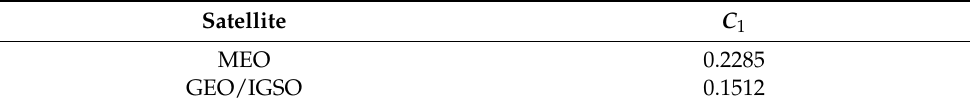
Table 4. Values of C 1 for satellites of different orbit